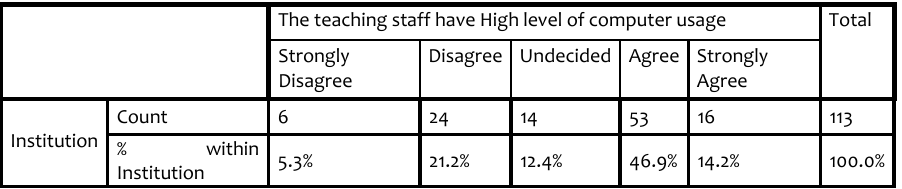
Table 3: The teaching staff level of computer